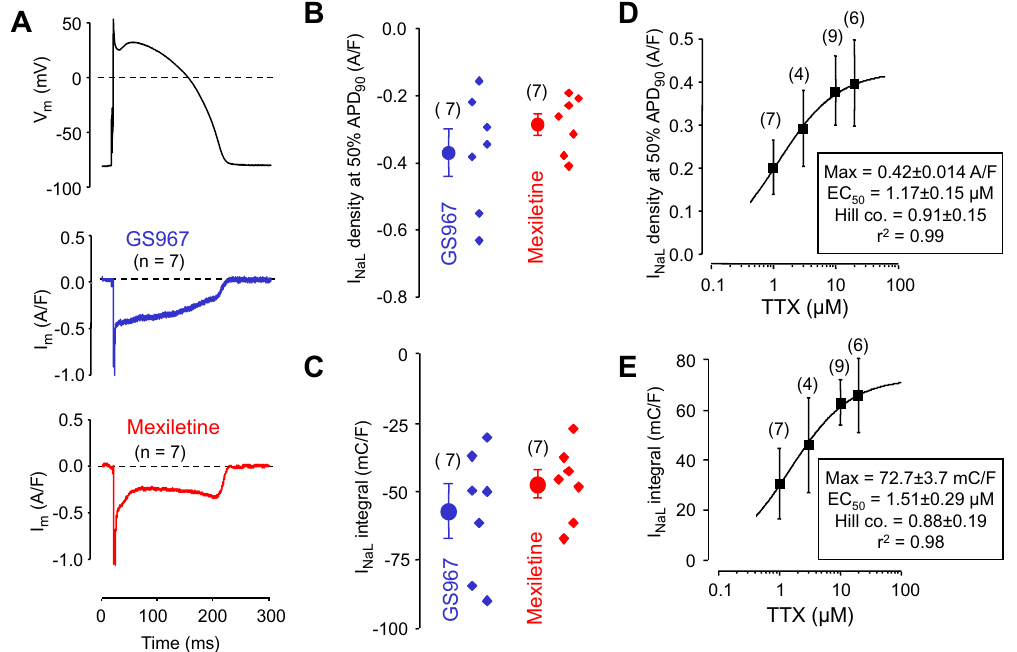
Figure 3. Effects of GS967 and mexiletine in isolated canine ventricular myocytes under action potential voltage clamp conditions. ( A ) Average membrane current profiles dissected by 1 µM GS967 and 40 µM mexiletine (in 7 myocytes in both cases), respectively, in the presence of 1 µM nisoldipine + 1 µM E4031 + 100 µM chromanol 293B. The command AP is shown above the current traces. ( B ) Current densities measured at 50% duration of APD 90 of the command AP. ( C ) Current integrals from which the initial 20 ms period was excluded. ( D , E ) Concentration-dependent effects of TTX on the density and integral of I NaL . The solid line was obtained by fitting data to the Hill equation. For conventional reasons the polarity was ignored in these latter plots. Symbols and bars denote mean ± SEM values, small dots represent individual data, numbers in parentheses indicate the number of myocytes